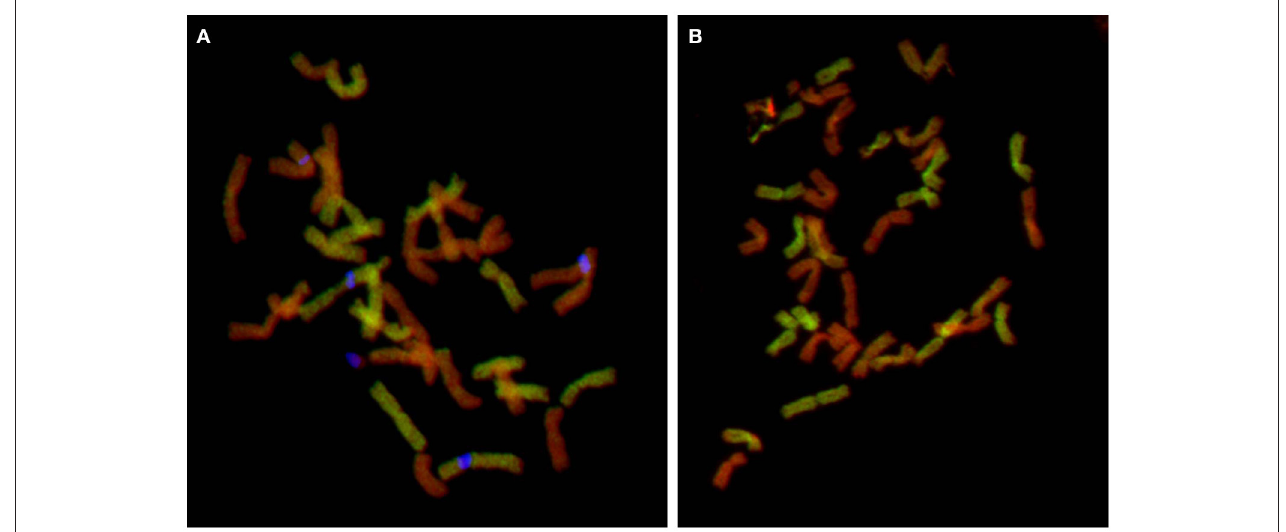
FIGURE 5 | Cytogenetic analysis of pentaploid hybrid. GISH with two probe combinations: (A) gDNA of F. pratensis (green color) and 45S rDNA (blue pseudocolor) and blocking DNA from sheared gDNA of F. glaucescens and (B) gDNA of F. glaucescens (green color) and blocking DNA from sheared gDNA of F. pratensis . Chromosomes were counterstained with DAPI (red pseudocolor). In the first combination, F. pratensis probe produced signal over 14 chromosomes (representing two sets of F. pratensis chromosomes: one from F. apennina and other from F. arundinacea ) and other 21 chromosomes remained unlabeled (one